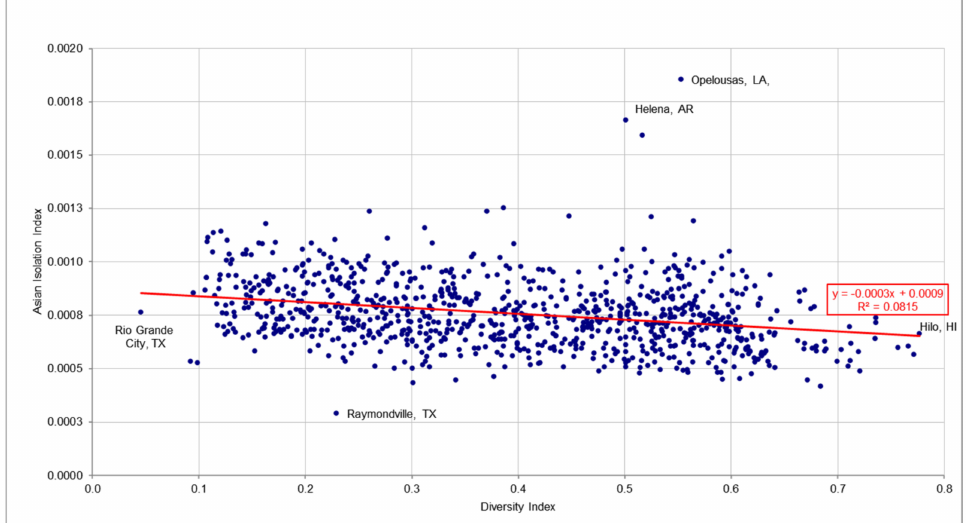
Figure 29. Relationship Between Diversity and Asian